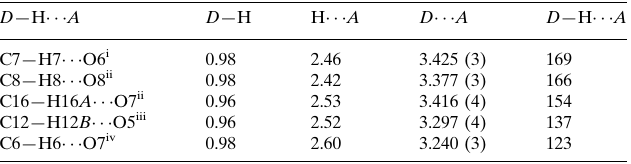
Hydrogen-bond geometry (A˚ , (cid:2)